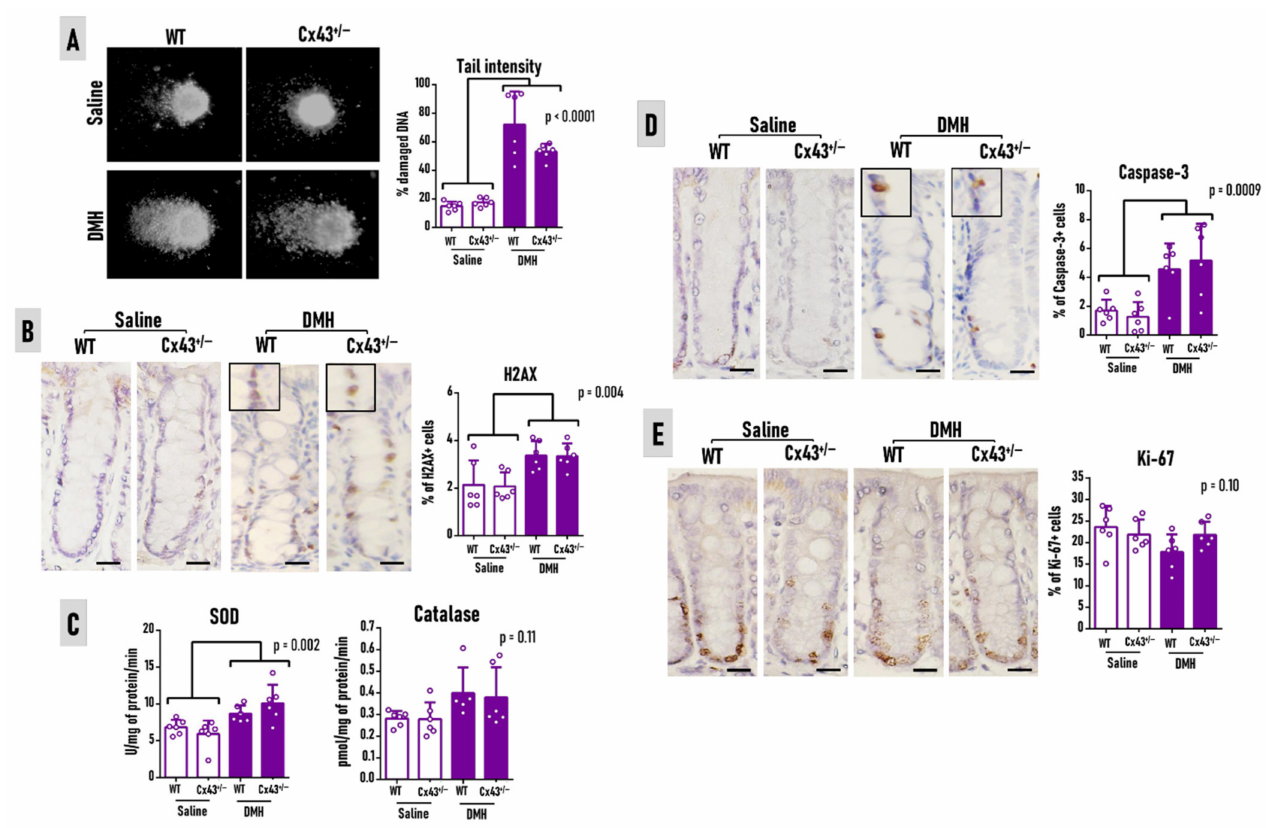
Figure 3. Implications of connexin 43 heterologous deletion (Cx43 +/ − ) on ( A ) peripheral blood genotoxicity, ( B ) colonocyte genotoxicity (H2AX), ( C ) antioxidant superoxide dismutase (SOD) and catalase enzymes, ( D ) epithelial crypt apoptosis (caspase-3), and ( E ) epithelial crypt proliferation (Ki-67) during 1,2-dimethylhydrazine (DMH)-induced colon carcinogenesis in C57BL/6J mice at week 7. ( A ) Representative nucleoids of the comet assay are presented. ( B , D , E ) A representative microscopic overview (scale bar: 20 µ m) and semiquantitative analysis of H2AX, Ki-67, and cleaved caspase-3 immunostaining in the colonocytes in both genotypes are presented. WT: wild-type. n = 6 mice/group/genotype. Data were presented as mean + standard deviation and data